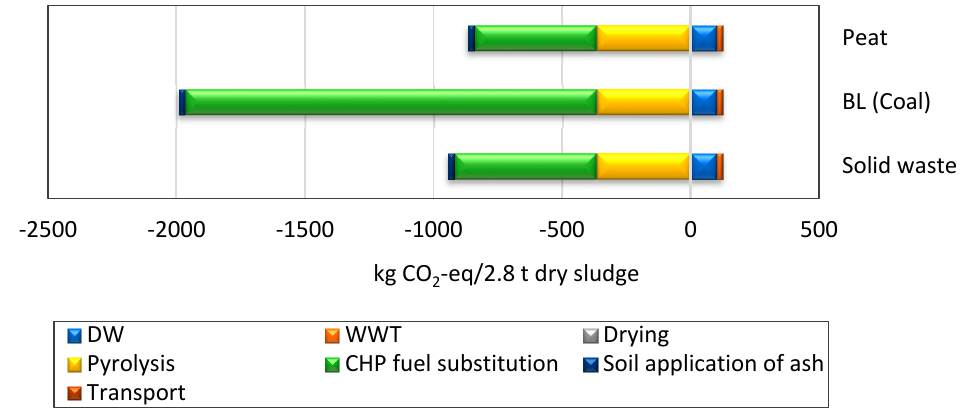
Figure 7. Sensitivity of the GHG abatement of Pyrochar Scenario to the avoided CHP plant fuel (peat and solid waste).